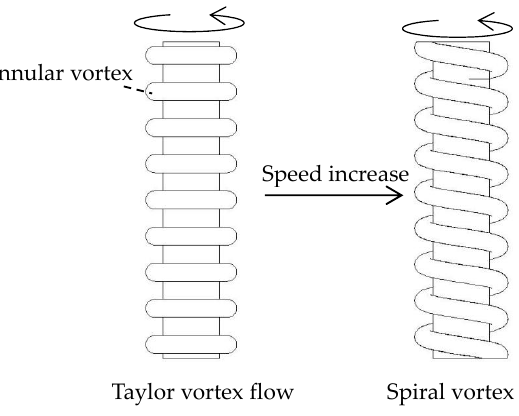
Figure 2. Schematic diagram of from Taylor vortex flow ( TVF) to spiral vortex flow ( SVF).